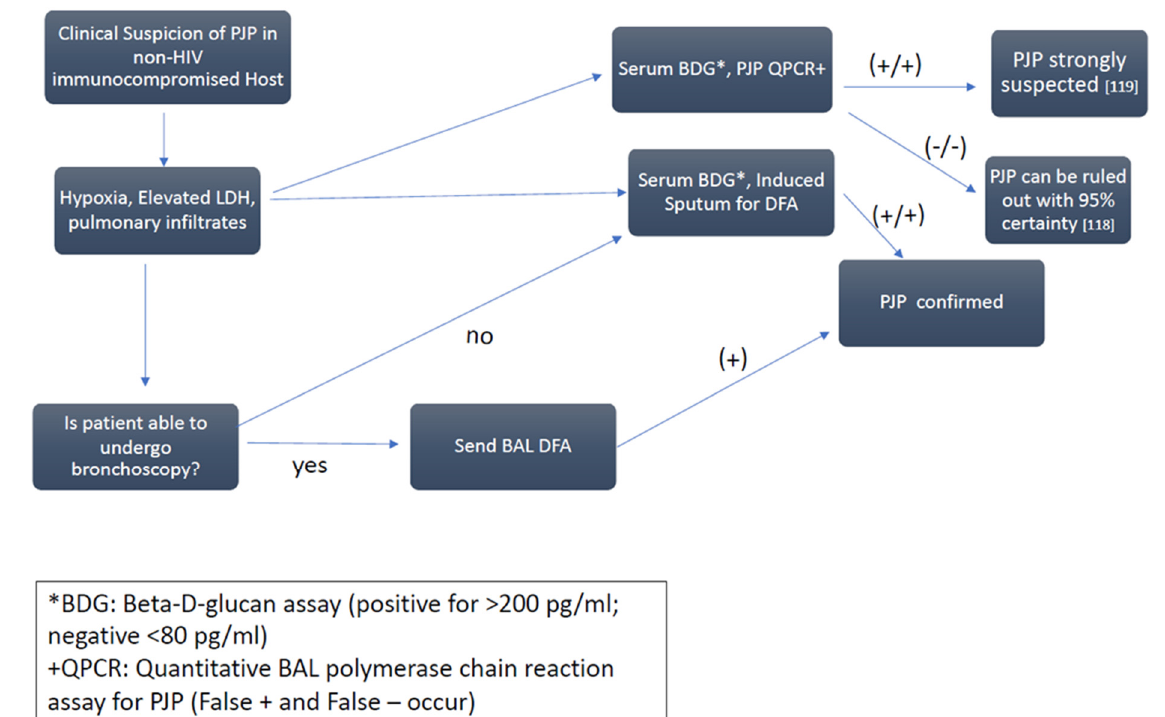
Figure 2. Approach to the diagnosis of Pneumocystis pneumonia. In immunocompromised patients at risk for Pneumocystis jirovecii pneumonia (PJP), early antimicrobial therapy is initiated based on clinical signs and symptoms, radiology, and available laboratory data [118,119]. Microbiological demonstration of organisms on bronchoalveolar lavage (BAL) or induced sputum specimens should not delay treatment. Other processes, including co-infections, may alter the radiologic picture or mimic PJP clinically.